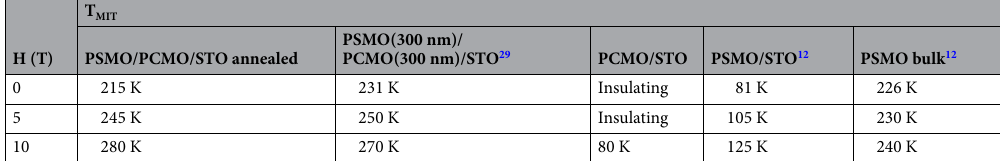
Table 1. Comparison of the T MIT at 0 T, 5 T, and 10 T of ultra-thin PSMO/PCMO/STO heterostructure with the thicker heterostructure PSMO(300 nm)/PCMO(300 nm)/STO, PSMO/STO single layer, PSMO bulk, and PCMO/STO single layer thin